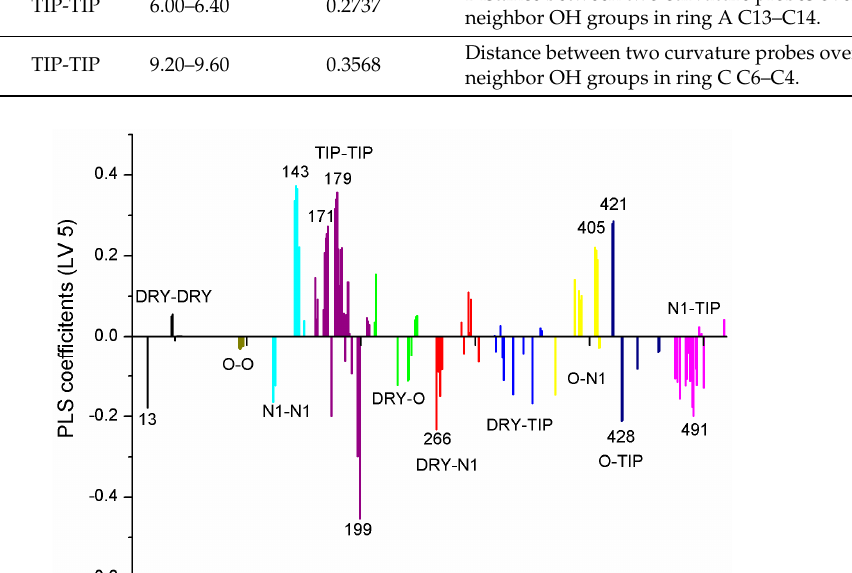
Figure 2. PLS coefficients in the Leishmania arginase inhibitors’ QSAR model.